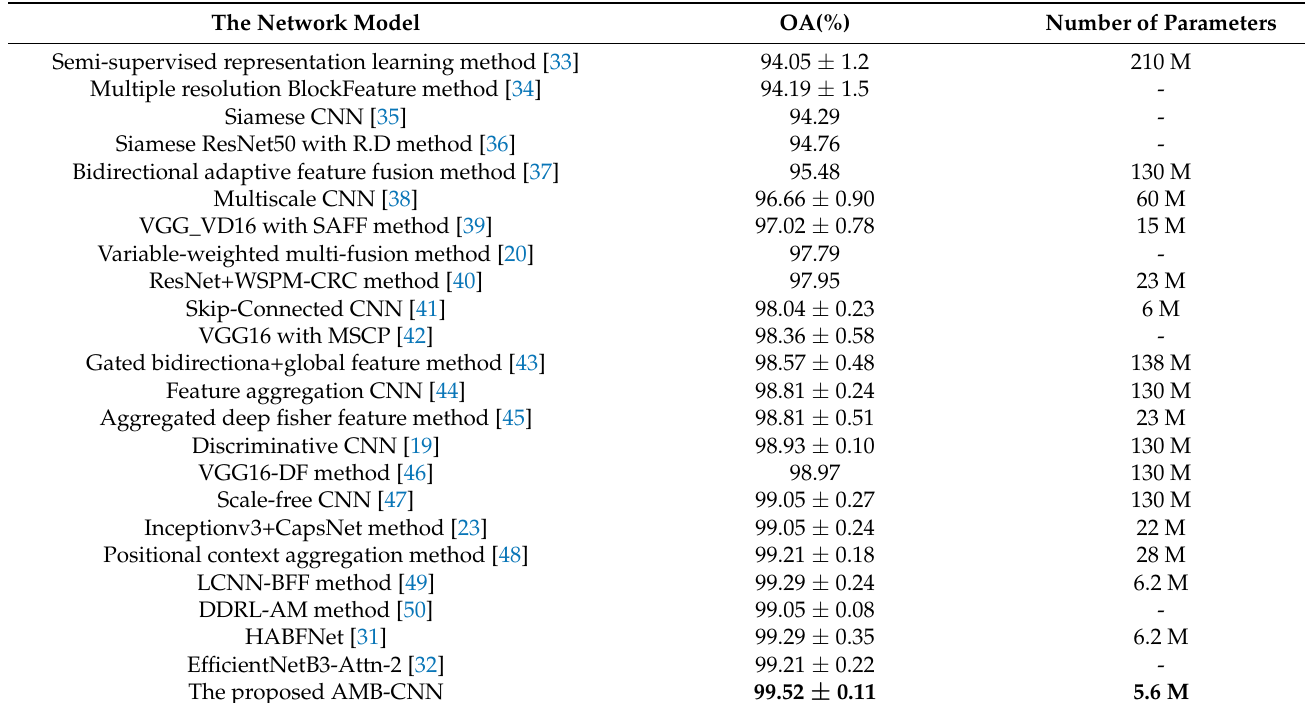
Table 2. Performance comparison of the proposed model with some state-of-the-art methods on the UCM21 dataset. The Network